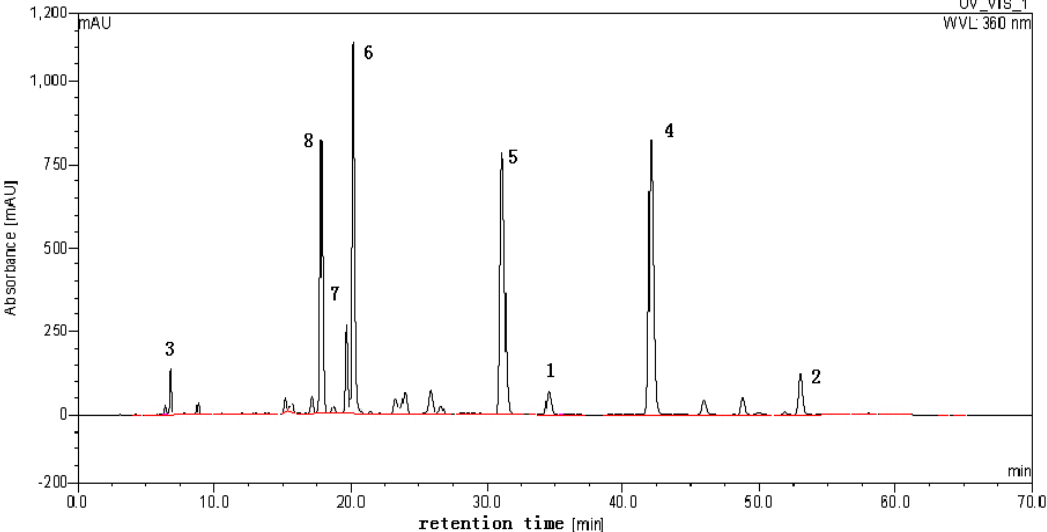
Figure 1. HPLC analysis of the GHE and peak fractions from